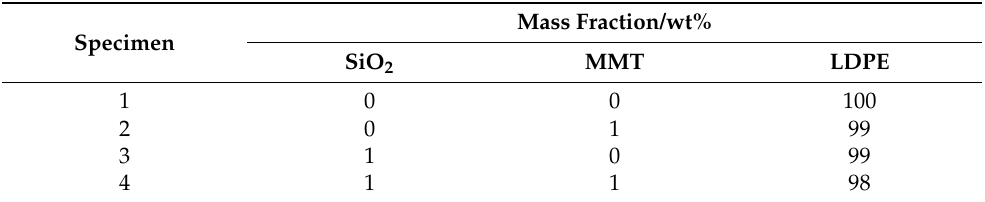
Figure 1. Material preparation process. Table 1. The composition and content of each composite material. Table 1. The composition and content of each composite material. Specimen Specimen